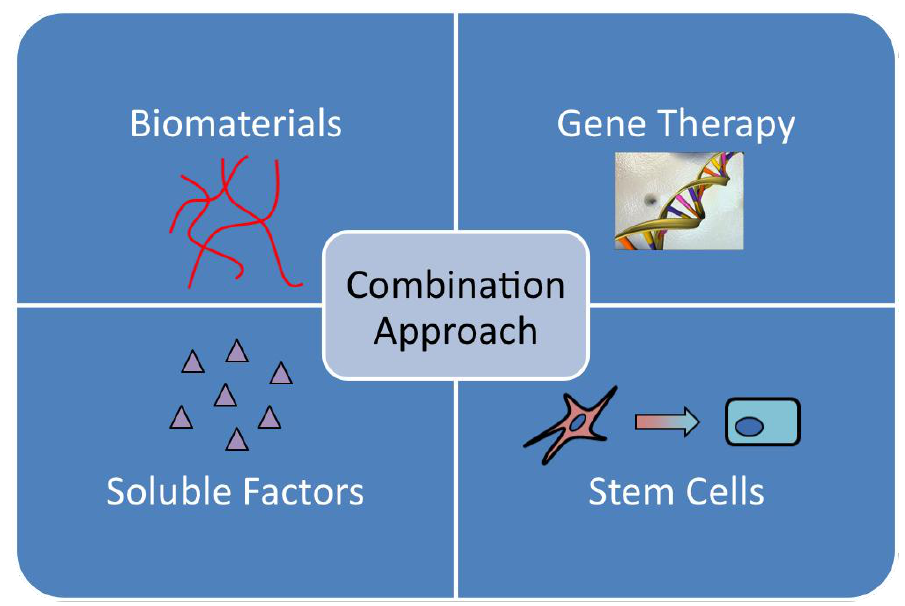
Figure 1. Current Strategies to Revitalize Bone